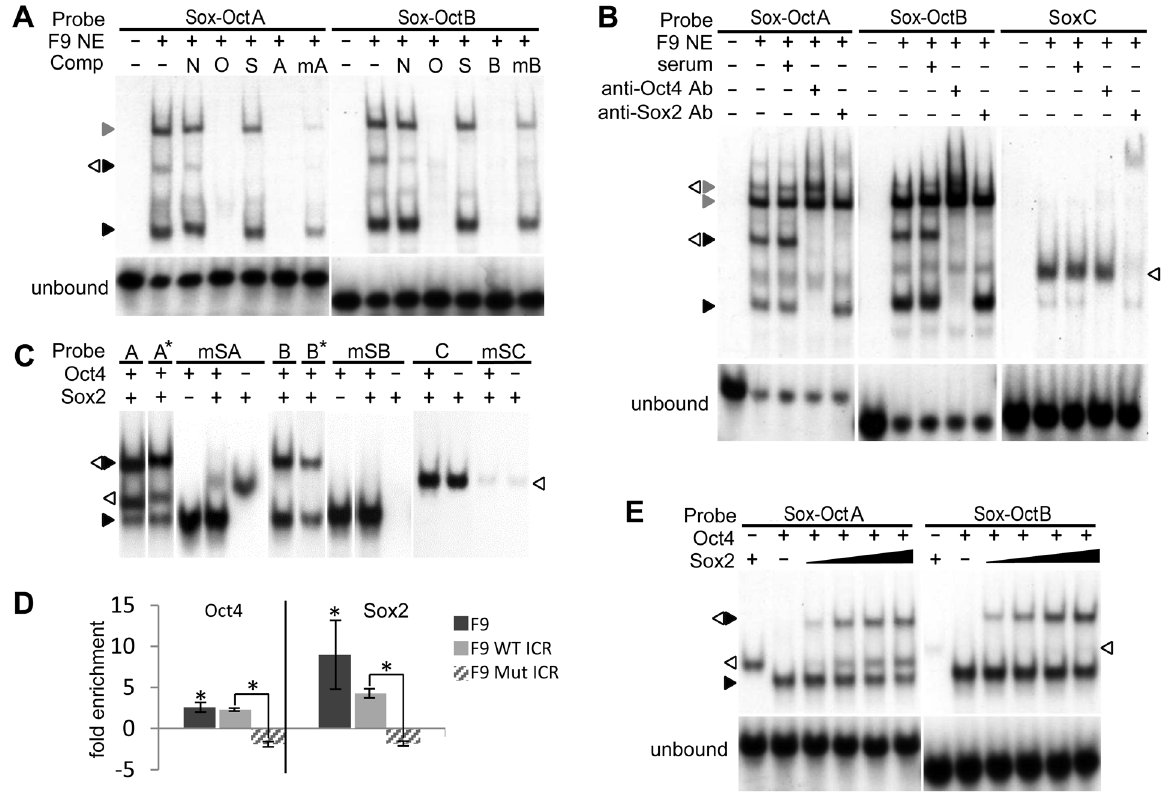
Figure 2. Sox2 and Oct4 binding to the ICR. EMSAs were performed using WT or mutant ICR probes as indicated with either F9 NE ( A, B ) or recombinant Oct4 and Sox2 ( C, D, F ). ( A ) The effect of octamer specific point mutations on Oct4 and Sox2 binding was assessed by addition of nonspecific (N) and specific unlabeled DNA competitors - oct (O), sox (S), ICR Sox-OctA and B (A and B), or mutant ICR Sox-OctA and B (mA and mB). ( B ) Oct4 and Sox2 supershift assays. Sox2 and Oct4 protein-DNA complexes (white and black triangles respectively) were identified by their respective antibodies (Ab). Presumptive Oct1 complexes are indicated by a grey triangle. ( C ) Recombinant Sox2 binding to Sox-OctA, B and SoxC. ICR probes with mutations to the Sox elements (mSA, mSB, and mSC) were used to confirm Sox2 binding sites. ( D ) Methylation-independent binding of Oct4 and Sox2 to the ICR Sox-Oct motifs Wild type ICR Sox-OctA and B probes (A* and B*) were methylated at all CpGs. ( E ) Oct4 and Sox2 ChIP assays. Enrichment of endogenous F9 or WT and mutant transgenic ICR octamers by Oct4 and Sox2 ChIP was determined by qRT-PCR and normalized to serum controls. Error bars represent standard deviation of the mean (n=3). Statistical significance of Oct4 and Sox2 enrichments was shown using Student’s t-test (*p , 0.05). ( F ) Cooperative binding of Sox2 to Oct4 complexes. Cooperative binding characteristics of Sox2 to the ICR were assessed by measuring the amount of binary and ternary protein-DNA complexes formed using a fixed amount of Oct4 and increasing amounts of Sox2. See Table S1 for a complete list of probe and competitor